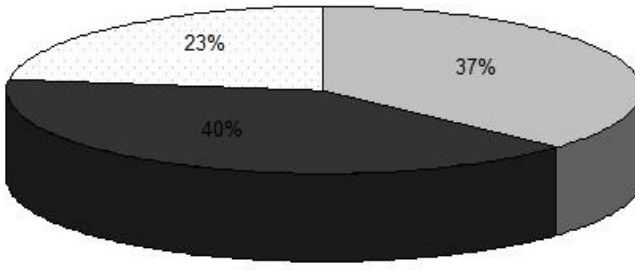
Figure 4. The responsibility of teaching safe hygiene and sanitation